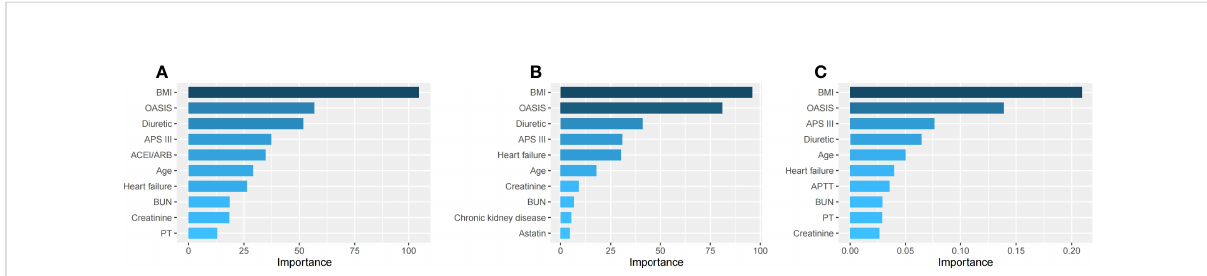
FIGURE 4 The top ten important factors of SA-AKI for the entire cohort in the decision tree model (A) , random forest model (B) and extreme gradient boosting model (C) . Models were adjusted for all variables, including age, BMI, ethnicity, admission type, hypertension, coronary atherosclerosis, heart failure, diabetes mellitus, COPD, cerebral infarction, chronic liver disease, chronic kidney disease, tumor, APS III, OASIS, SOFA, heart rate, MAP, RR, temperature, SpO2, WBC, hemoglobin, platelet, PH, bicarbonate, BUN, creatinine, potassium, sodium, chloride, glucose, PT, APTT, lactate, vasopressor use, mechanical ventilation use, diuretic, aminoglycoside, statin, ACEI/ARBs. ACEI/ARBs, Angiotensin-converting enzyme inhibitors/angiotensin receptor blockers; AKI, Acute kidney injury; APS III, Acute Physiology Score III; APTT, Activated partial thromboplastin time; BMI, Body mass index; BUN, Blood urea nitrogen; COPD, Chronic obstructive pulmonary disease; OASIS, Oxford Acute Severity of Illness Score; PT, Prothrombin time; SA-AKI, Sepsis associated acute kidney injury; SOFA, Sequential Organ Failure Assessment; RR, Respiratory rate; WBC, White blood cell.